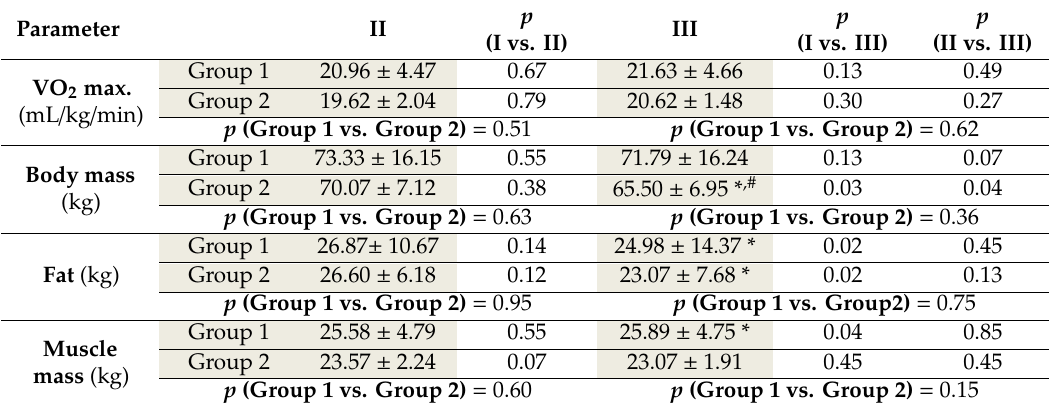
Table 2. Anthropometric characteristics of participants after 6 (II) and 12 (III) weeks of training ( n = 15).